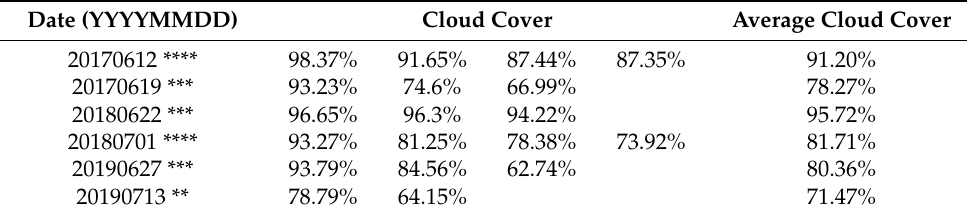
Table 3. Statistical table of cloud cover information in the date when FAI-COM was not able to extract U. prolifera .